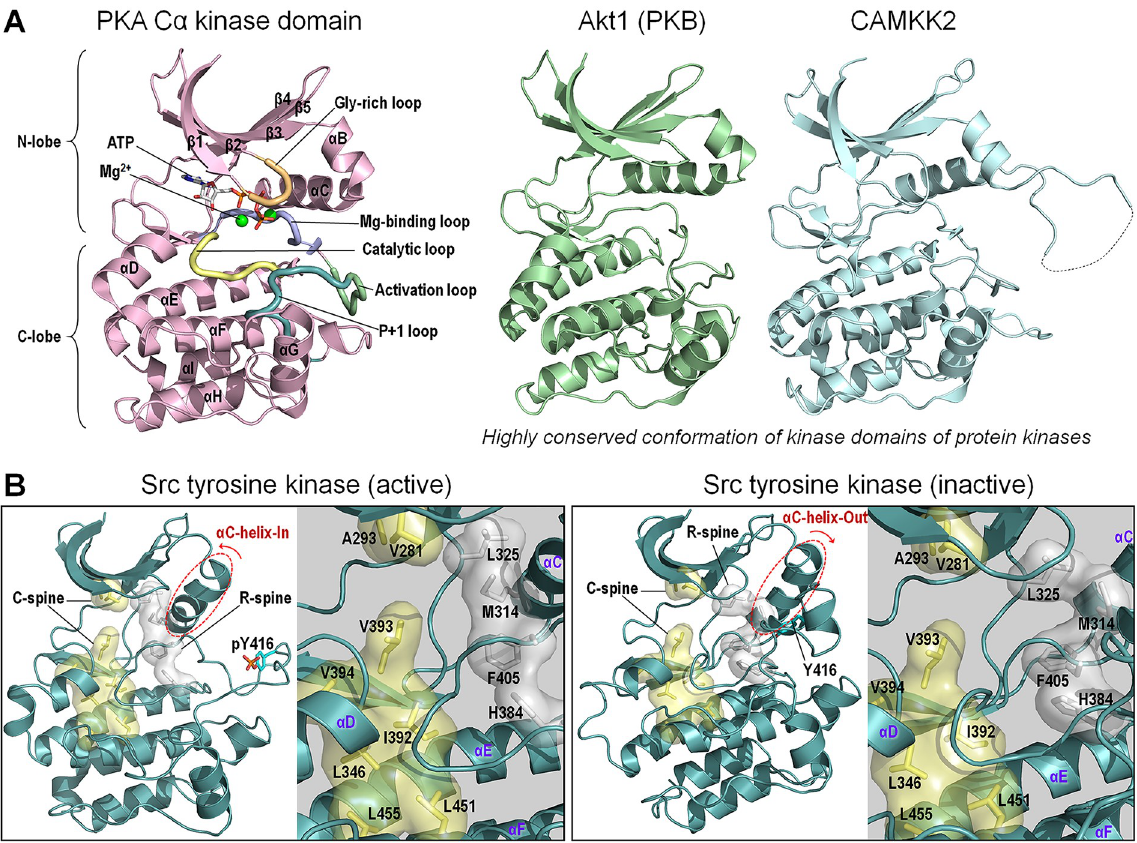
Fig 6. Kinase domain structures of protein kinases. (A) Crystal structure of kinase domain of cAMP-dependent PKA C α in the active state (PDB code: 4DH3). PKA is a member of the AGC kinase family. The kinase domain conformation is highly conserved among other protein kinases. Examples are shown for crystal structures of Akt1 (PDB code: 6CCY) and CAMKK2 (PDB code: 5UYJ). Akt is known as PKB and belongs to the serine/threonine-specific protein kinase family. CAMKK2 is a member of CaM kinase family. (B) Crystal structures of kinase domain of proto-oncogene tyrosine-protein kinase Src in the active (PDB code: 1YI6) and inactive (PDB code: 2SRC) states. Src is a member of the nonreceptor tyrosine kinase family. While C-spine is preserved, R-spine is significantly distorted in the inactive Src kinase domain due to outer movement of the α C-helix. AGC, kinase group AGC; C-spine, catalytic spine; CaM, Calmodulin; CAMKK2, Calcium/Calmodulin dependent protein kinase kinase 2; cAMP, cyclic AMP; PDB, protein data bank; PKA C α , protein kinase catalytic subunit α ; PKB, protein kinase B; R-spine, regulatory